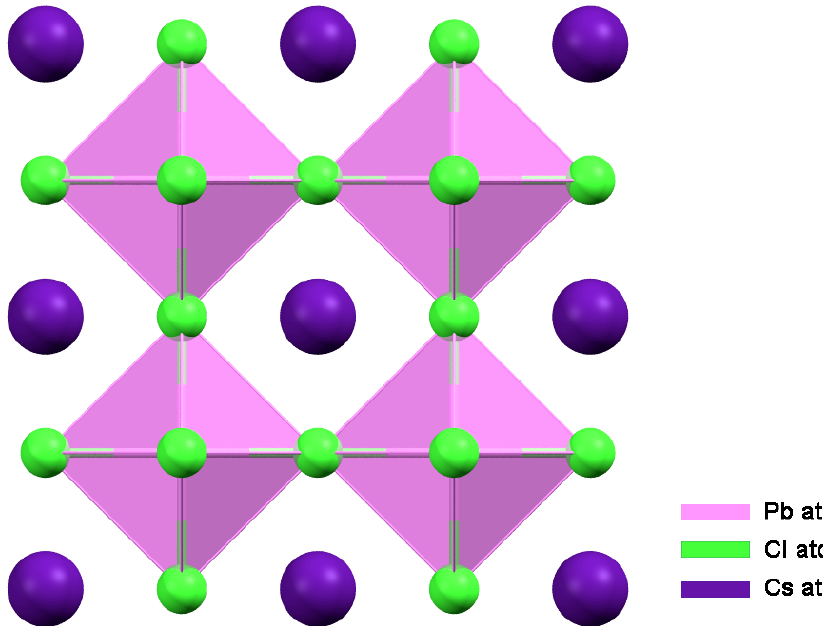
Figure 5. Structure of CsPbCl 3 perovskite is based on crystal structure from ICSD database 201250